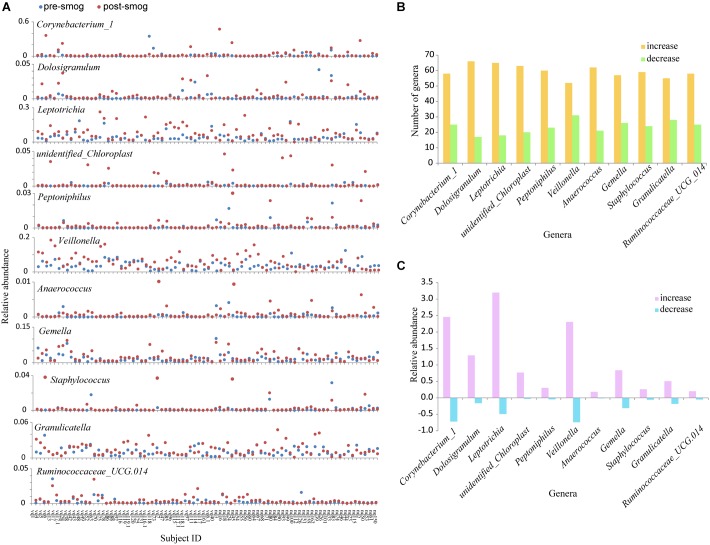
The changes in the relative abundance of the 11 genera showing positive correlations with the smog event. (A) The changes in the relative abundance of the 11 genera in each subject. (B) The increased and decreased subject numbers for the 11 genera. (C) The total increase and decrease in the relative abundances of the 11 genera in the 83 subjects.